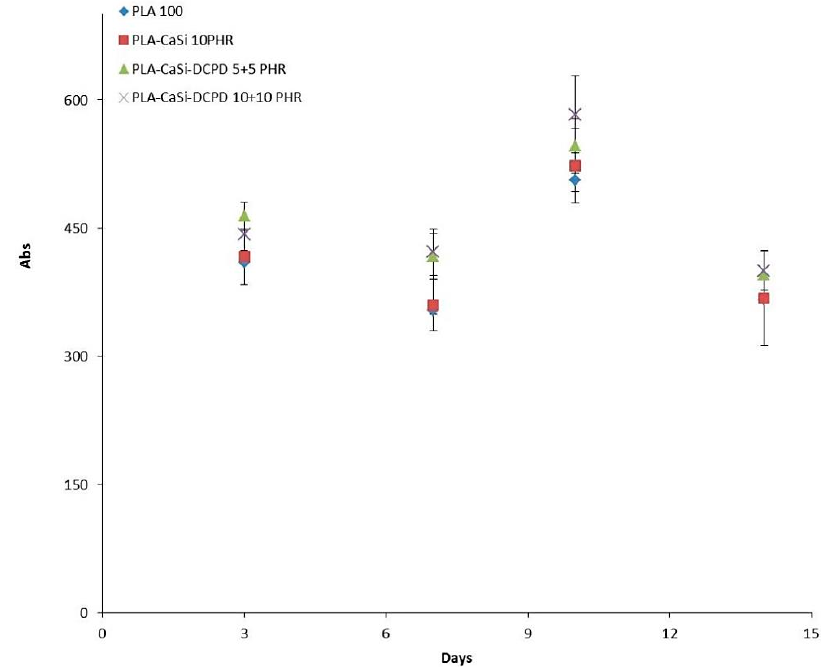
Figure 8. Proliferation curve. Quantitative results of hPCy-MSCs proliferation seeded on PLA scaffolds measured by the Prestoblue metabolic activity assay (absorbance (Abs) in the Y axis) at days 3, 7, 10, and 14 of culture (Time in the X axis). Error bars represent standard deviations.